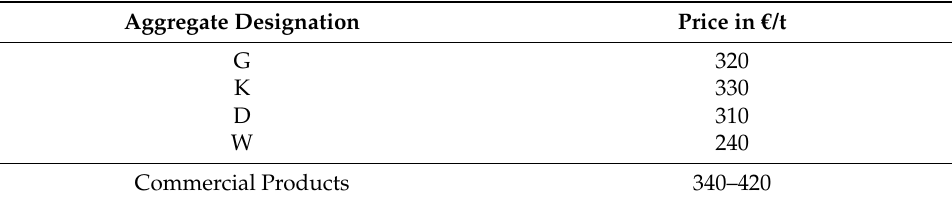
Table 7. Assumed total price of aggregates produced by pilot experiments compared to products available on the